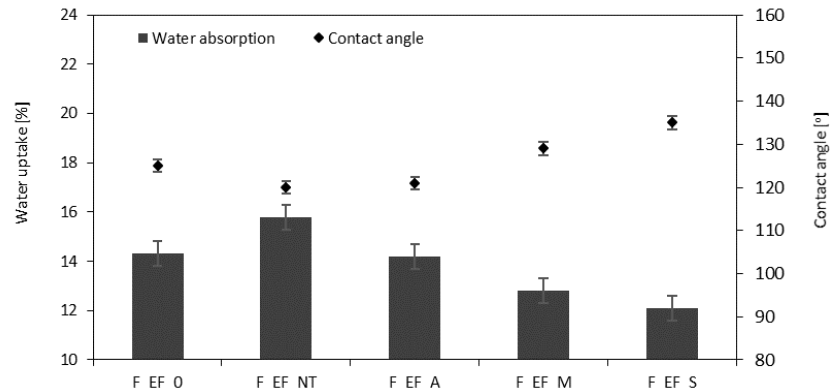
Figure 12. Water uptake of polyurethane (PUR) foams.